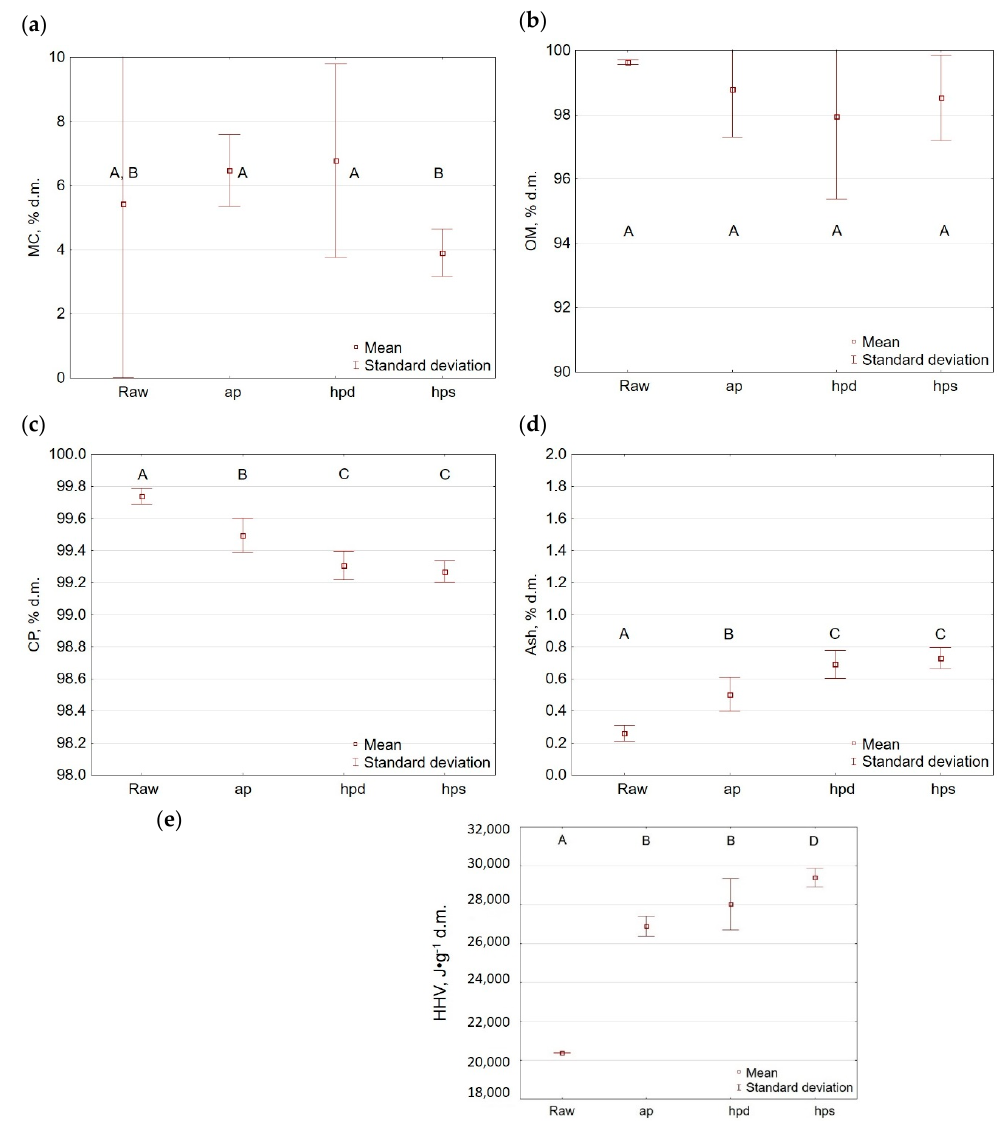
Figure 16. The results of the post-hoc HSD Tukey’s test for proximate analysis of torrefied pellet ( a ) moisture content (MC), ( b ) organic matter content (OM), ( c ) combustible part (CP), ( d ) ash, ( e ) high heating value (HHV).